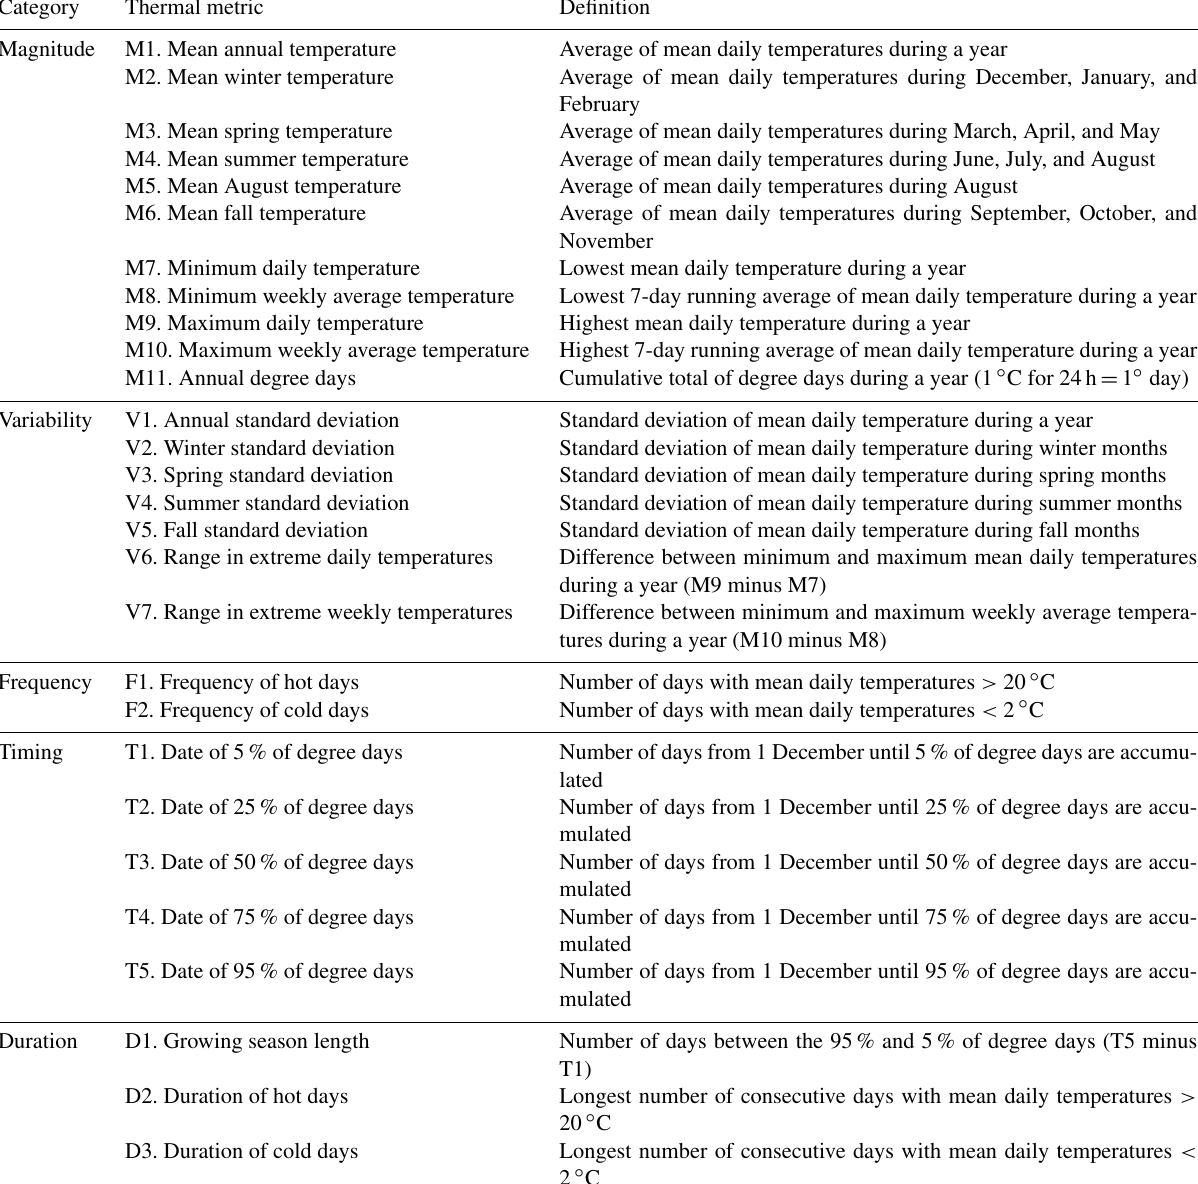
Table 2. Temperature metrics used to describe thermal regimes of mountain rivers and